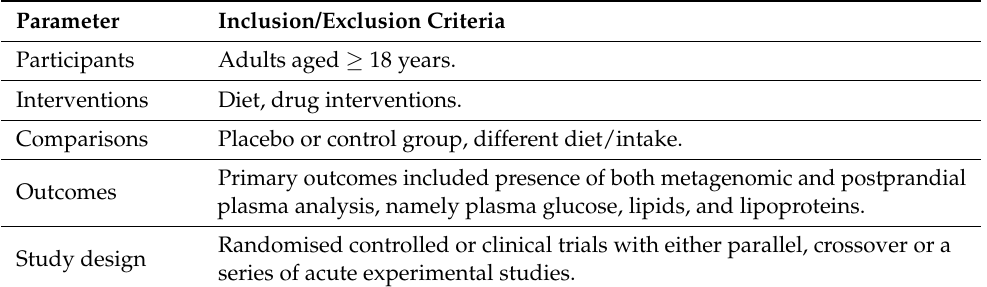
Table 2. PICOS (Population, Intervention, Comparison, and Outcomes) table summarising study